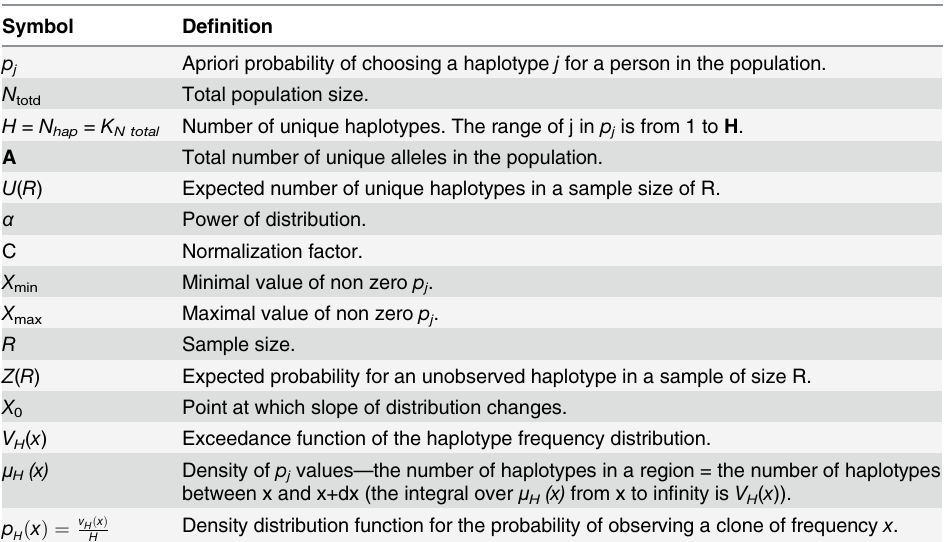
Table 1. List of symbols